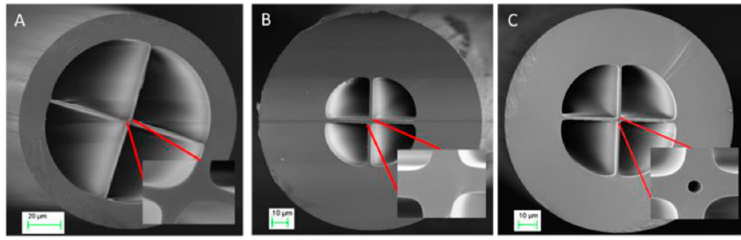
Figure 22. ( A ) SSC-1; ( B ) SSC-2; ( C ) SSC-3 cross section. In every figure, the detail of the core geometry Figure 22. (a) SSC-1; (b) SSC-2; (c) SSC-3 cross section. In every figure, the detail of the core geometry